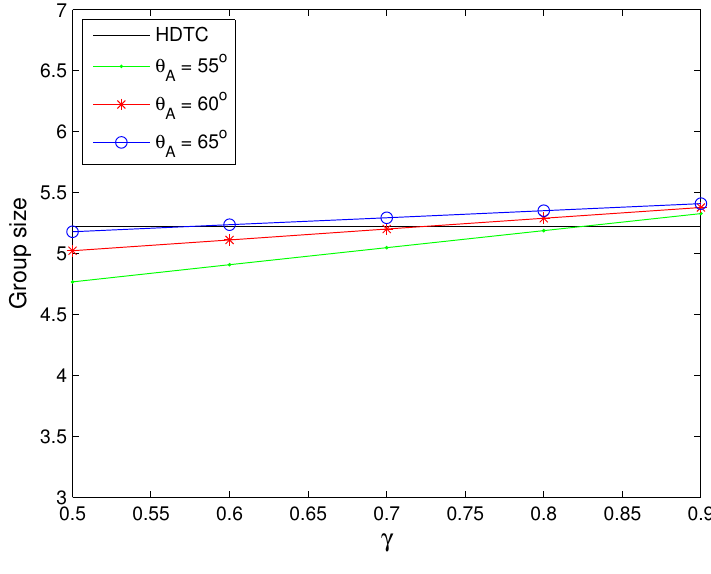
and the parameter γ A